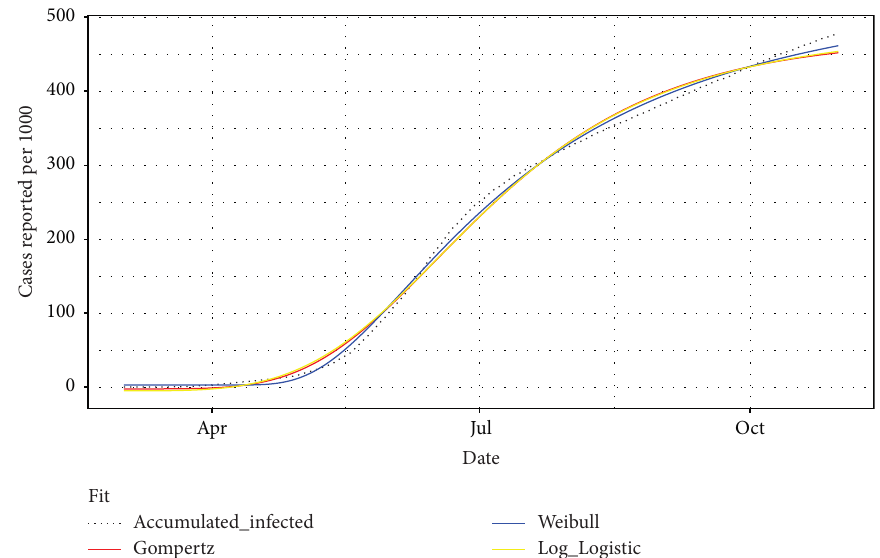
Figure 8: Fit of the growth curve models to the accumulated number of infected by COVID-19 in Chile (using data from March 2 to October 31, 2020).